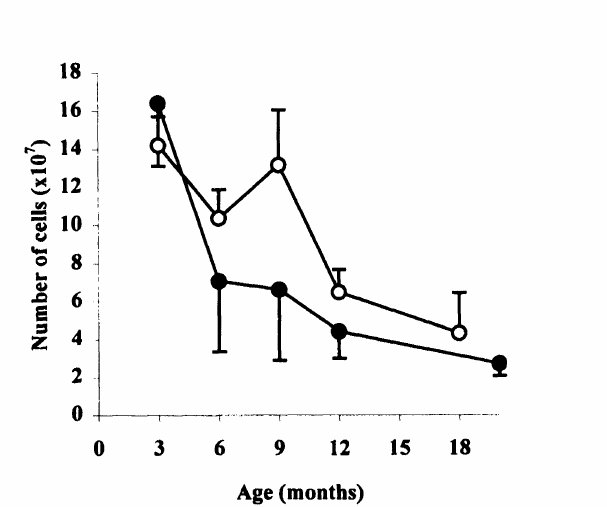
FIGURE 2 At 9 months of age and at no other time point there is a significant difference(P<0.01) in the total number of cells in the thymus of male (filled circles) and female (unfilled circles) mice (n=3-7 animals at each time